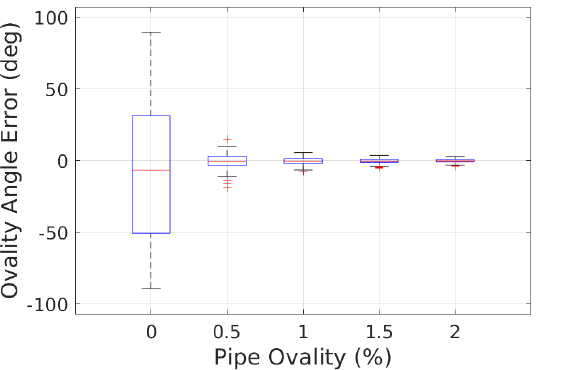
Figure 12. Ovality angle error of our SPPE for different pipe